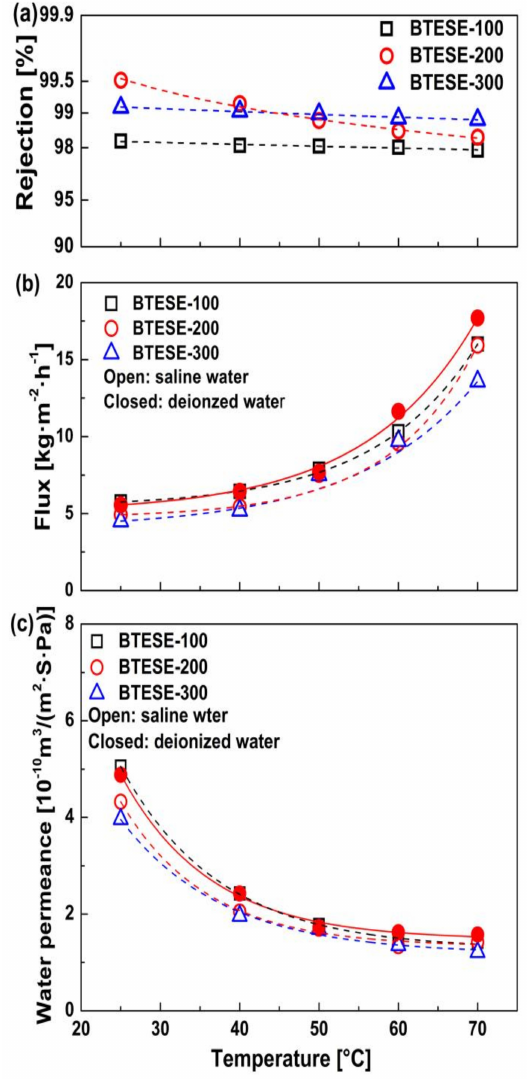
Figure 4. Temperature dependence of ( a ) NaCl rejection, ( b ) water flux, and ( c ) water permeance for the BTESE membranes at a feed concentration of 2000 ppm NaCl (closed circle: feeding with deionized water using the BTESE-200